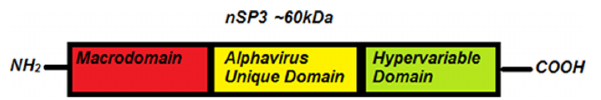
FIGURE 1 | Schematic diagram of nsP3. The nsP3 protein consists of three regions: macrodomain, alphavirus unique domain, and hypervariable domain. The macrodomain is highly conserved among all alphaviruses and contains the ADP-ribose-binding site. The alphavirus unique domain contains many serine and threonine residues and is the location of the zinc-binding site. The hypervariable domain comprises the final third of the protein at the C-terminal, containing many sites for phosphorylation. This region varies greatly among the alphaviruses in both length and sequence.